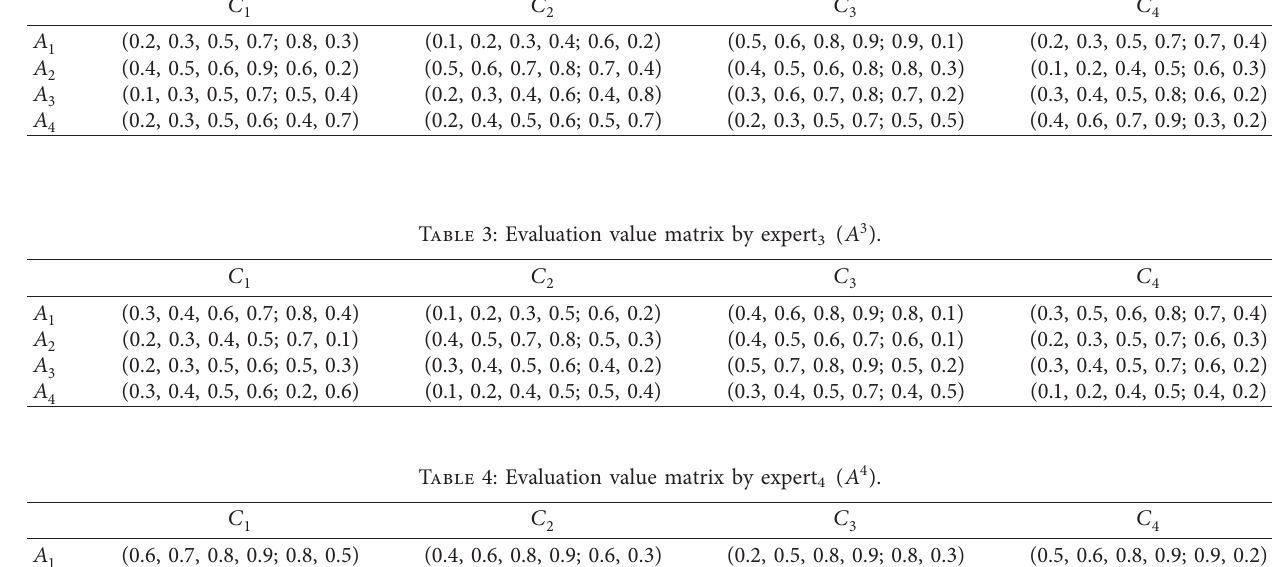
Table 2: Evaluation value matrix by expert